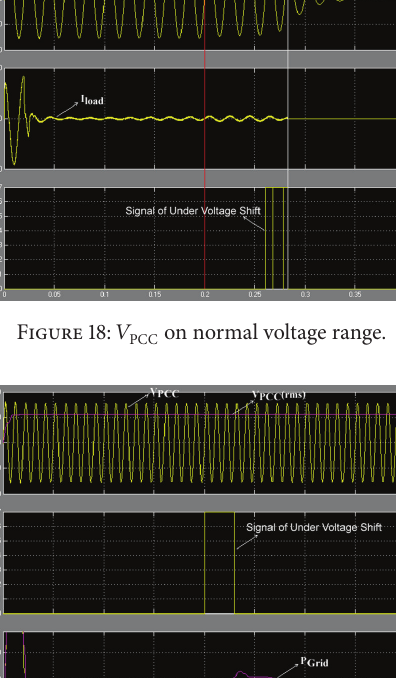
Figure 19: Injecting a signal to change the undervoltage in normal